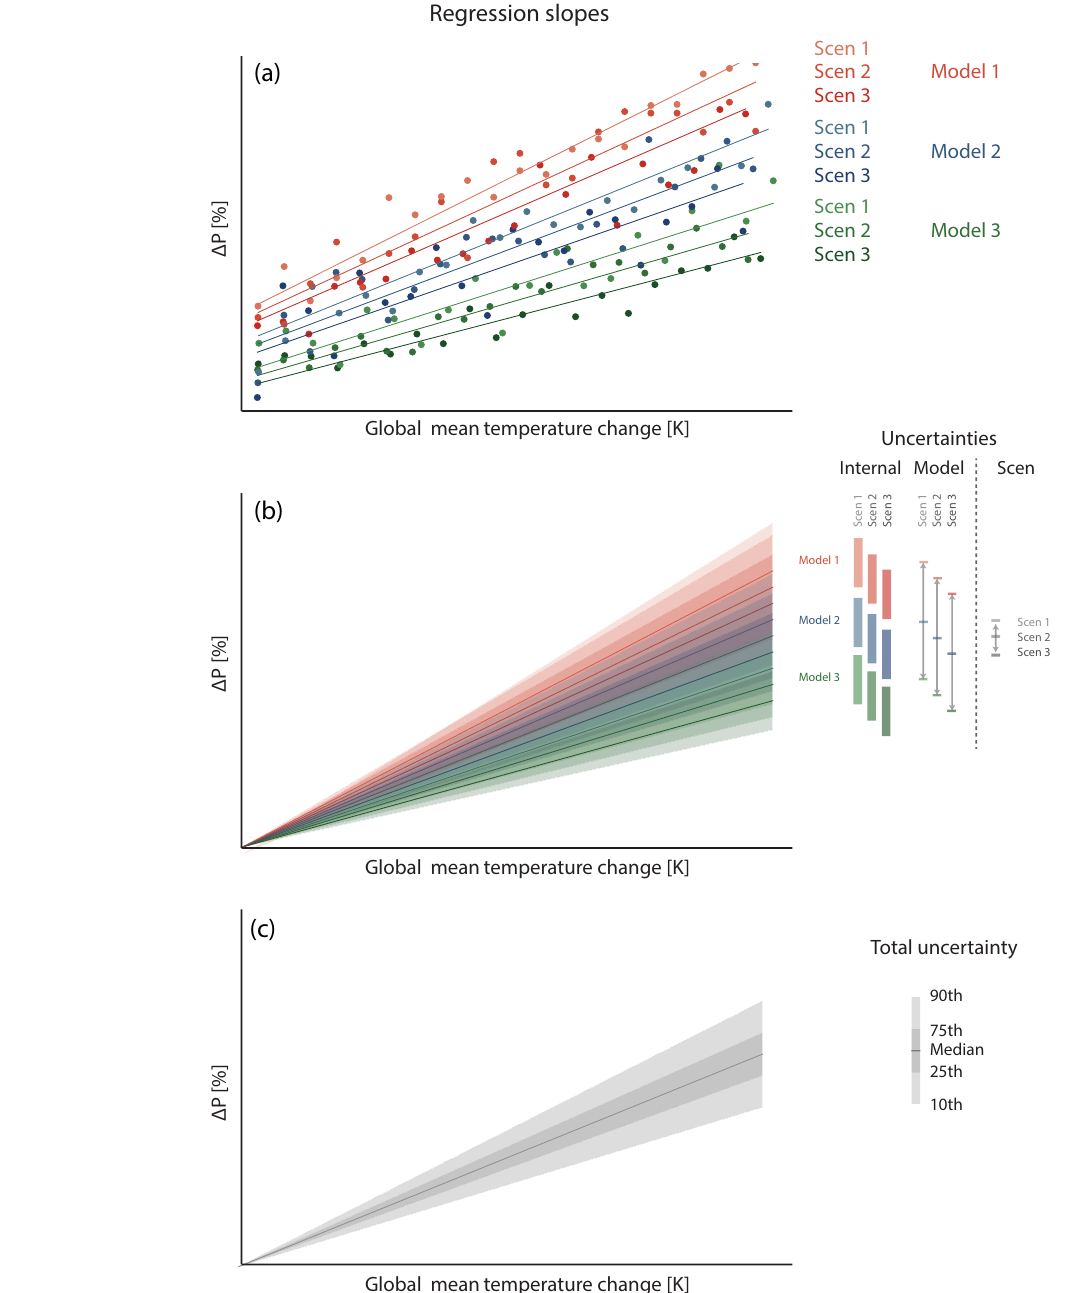
Figure 1. Conceptual illustration of deriving the uncertainty distribution of the scaling coefficient of P with respect to global warming from multiple models forced by multiple emission scenarios. (a) For each model under each scenario, we regress the relative change in mean-annual P ( (cid:49)P , with respect to a baseline period) against global mean T . We thereby obtain the regression slope which is the scaling coefficient of P to global warming. The year-to-year variability further causes the estimate of the slope to be uncertain. We account for this uncertainty by numerically estimating the uncertainty distribution of each model- and scenario-specific regression slope through resampling the residuals in a bootstrapping approach. (b) This uncertainty is associated with every model run and represents the internal variability. The average of the uncertainties stemming from the range of all individual models within a certain scenario represents the model uncertainty, and the uncertainty associated with the range of all scenario-specific multimodel means represents the scenario uncertainty. The uncertainty distribution is illustrated here as a function of global temperature increase. (c) The total uncertainty combines all sources of uncertainty and provides a conservative estimate of regional (cid:49)P as a function of global warming that can be used to assess either the median response or to study changes in any other quantile of the uncertainty